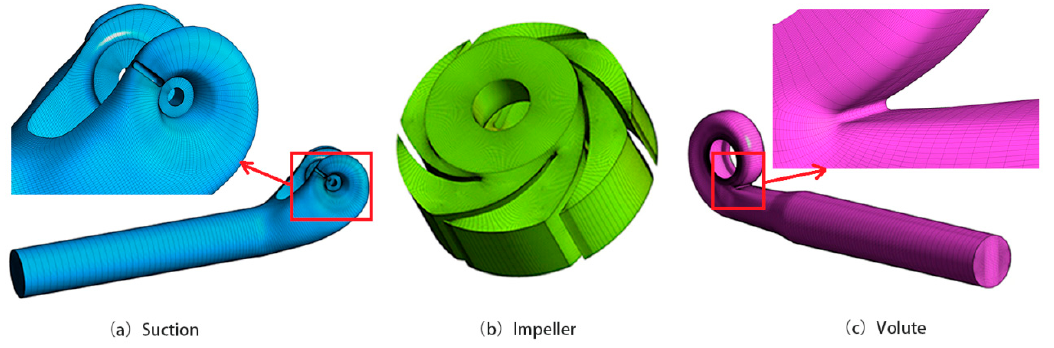
Figure 5. Computational mesh.